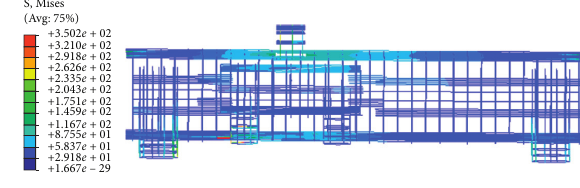
Figure 22: Steel bar stress nephogram of MT-1.